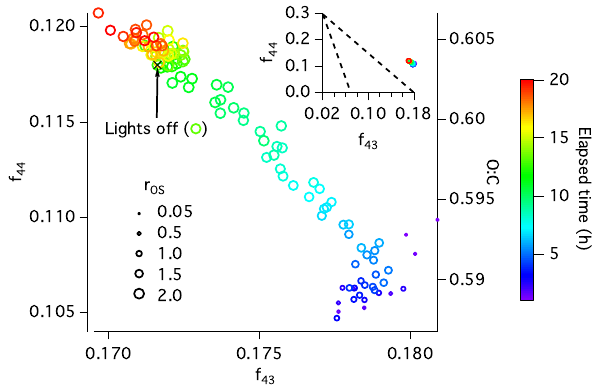
Fig. 9. Trends in m -xylene concentration (left axis) and 1M o (right axis) when irradiation is stopped once peak 1M o is attained. Fig. 10. Evolution of f 43 , f 44 , and O:C of m -xylene SOA. Irradi-